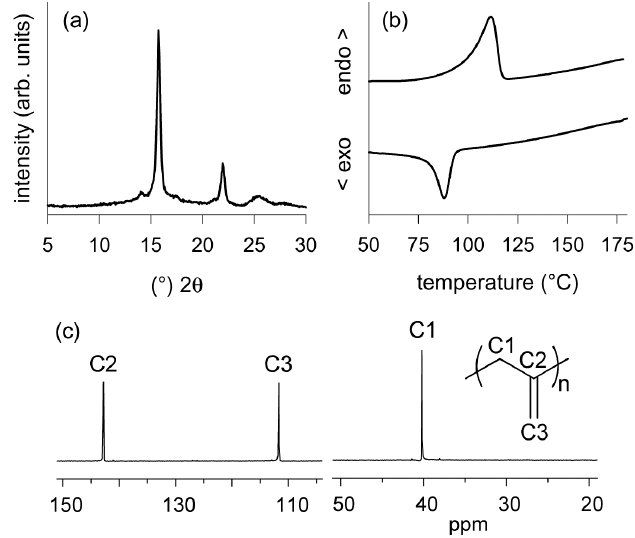
Figure 7. Powder X-ray Diffraction (PXRD) ( a ); Differential Scanning Calorimetry (DSC) ( b ) and 13 C NMR ( c ) spectra of poly(1,2-propadiene) (Table 3, entry 2).